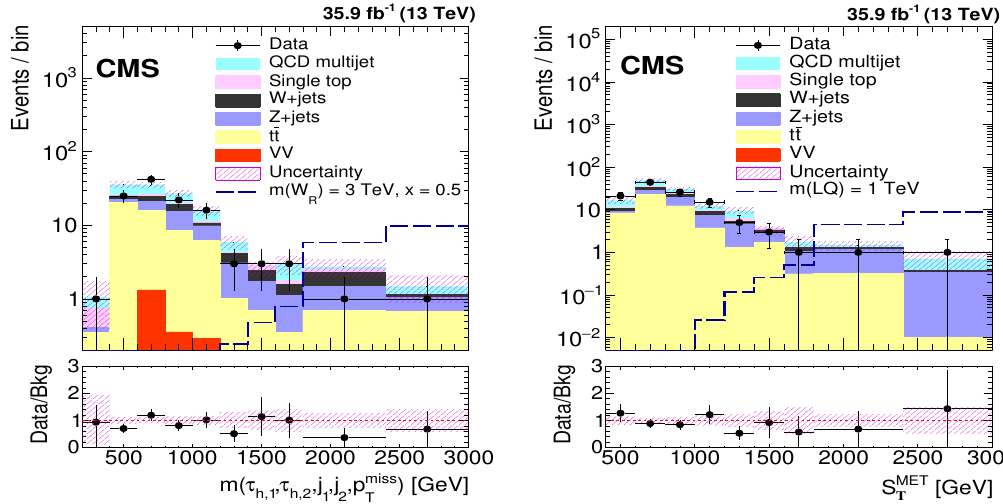
Figure 5 . Distributions in m ( (cid:28) h ground in the signal region. The heavy neutrino model with m (W R ) = 3 TeV and m (N is used as a benchmark in the m ( (cid:28) h m (LQ) = 1 TeV is used as a benchmark in the S MET ratio between the observed data and the background estimation; the band corresponds to the statis- tical uncertainty in the background. The tt, QCD multijet, and Z+jets contributions are estimated employing control regions in data and simulation, while the other contributions are obtained fully from the